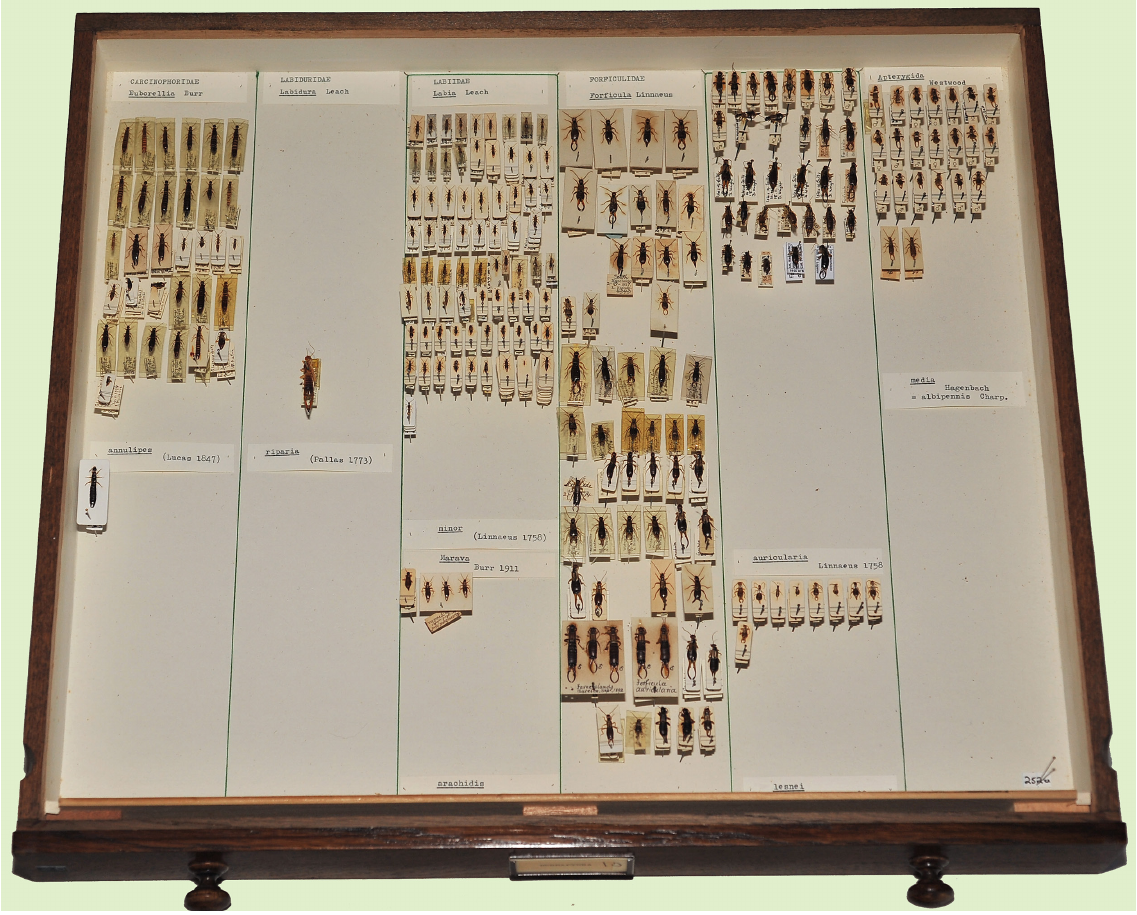
Fig. 3. A drawer of the British Dermaptera collection, the Manchester